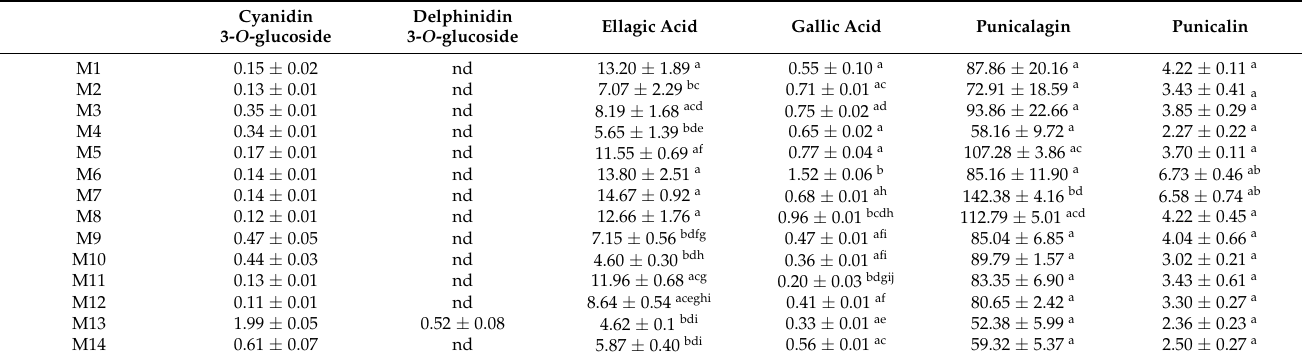
Table 3. Amounts of selected compounds detected in pomegranate peels